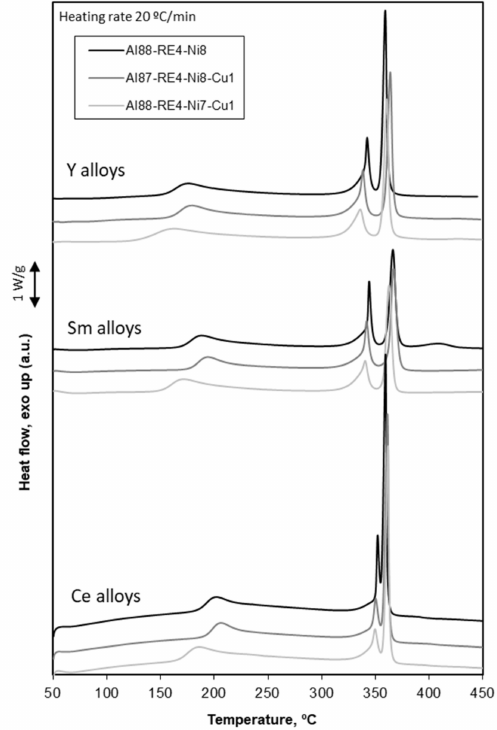
Figure 2. Di ff erential scanning calorimetry (DSC) traces at a heating rate of 20 ◦ C / min of Al-RE-Ni-(Cu) melt-spun